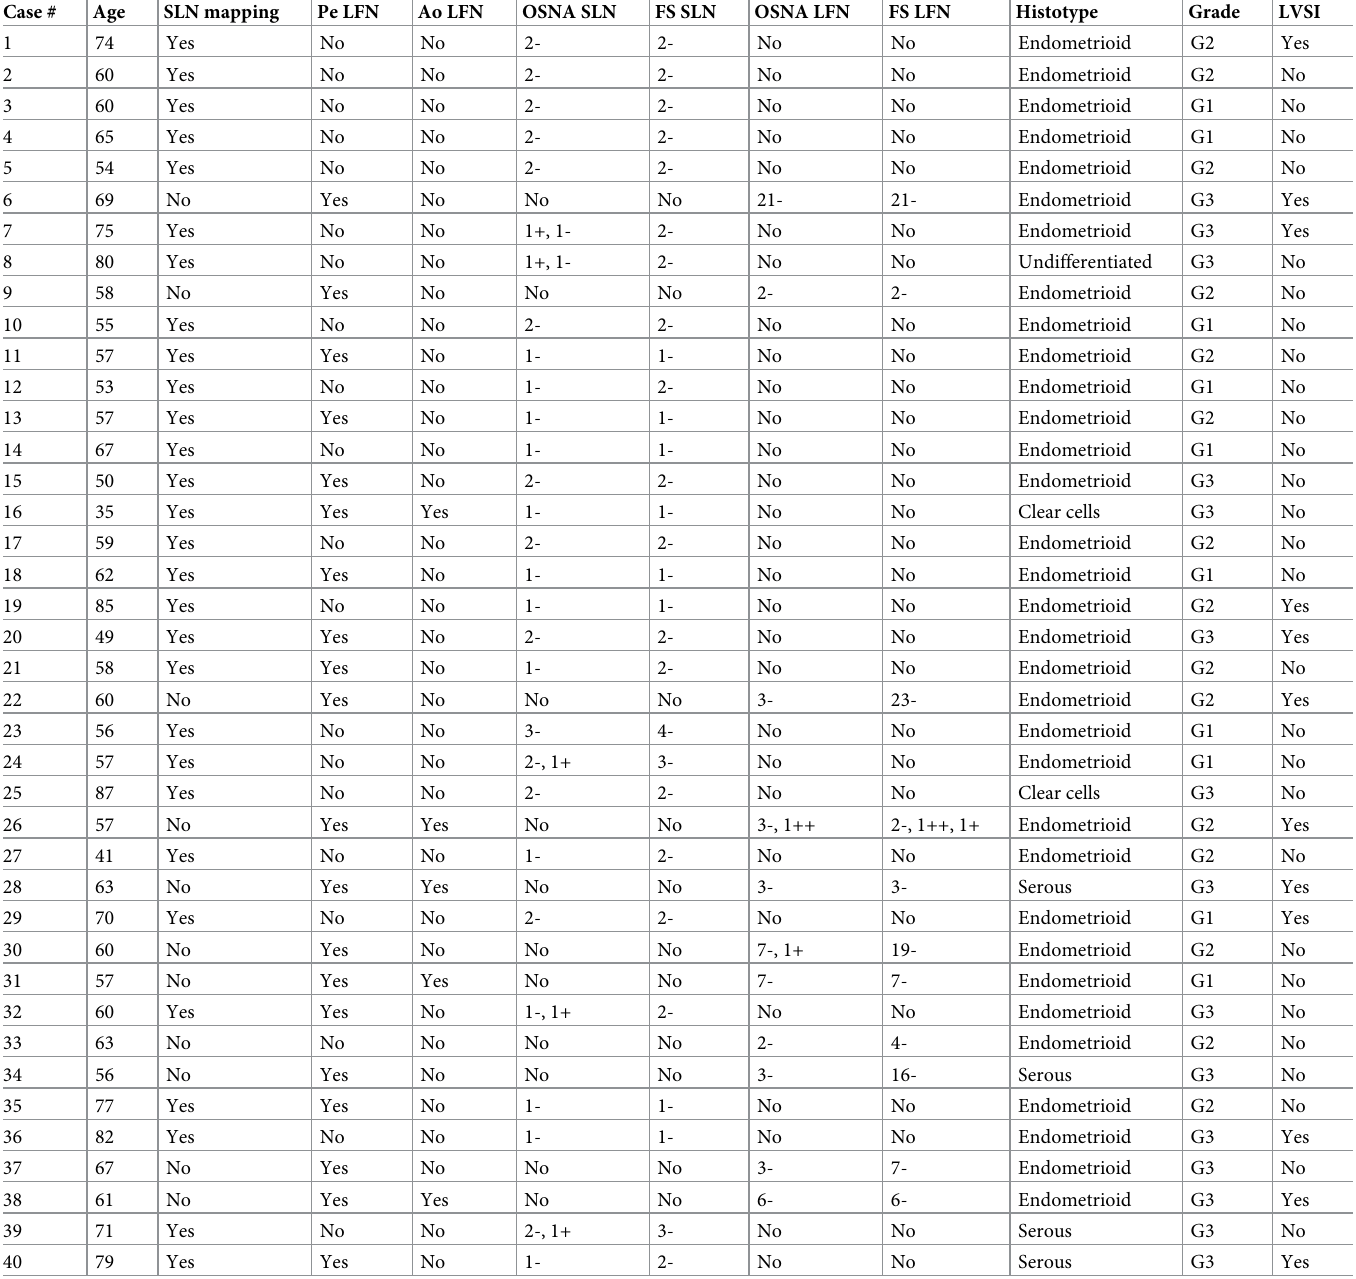
Table 2. Summary of clinical and histopathological